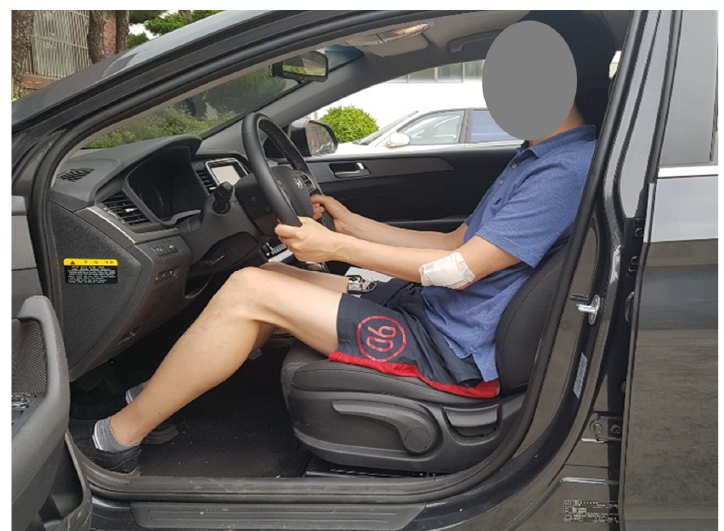
Figure 5 . Illustration of experimental scene .